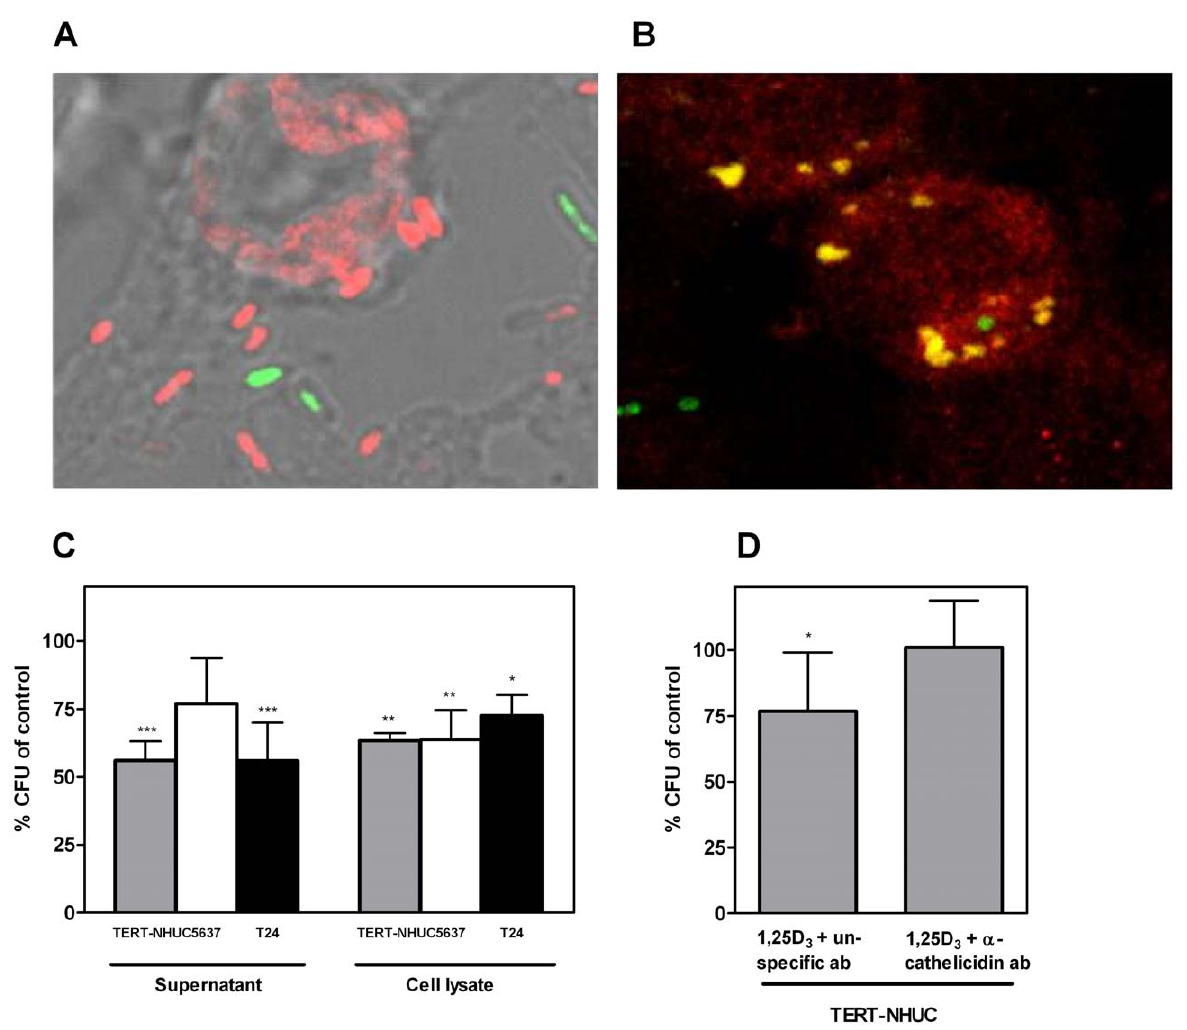
Figure 6. Vitamin D increases the cathelicidin-mediated antibacterial effect of bladder epithelial cells. Cell-associated UPEC are killed as determined with Live/Dead staining where live bacteria are stained green and dead bacteria are stained red ( A ). UPEC attach and invade bladder cells and are colocalized with cathelicidin. GFP-labelled E. coli CFT073 is green and cathelicidin is stained with AlexaFluor 594 (red); regions of colocalization are yellow ( B ). The antibacterial effect induced by 1,25D 3 was measured in medium from TERT-NHUC, 5637 and T24 bladder cells after stimulation for 48 hours. E. coli CFT073 was incubated in conditioned medium from treated cells for 90 minutes (Supernatant). Cells from the same experiment were harvested and lysed (Cell lysate). The resulting bacterial count is shown as percentage of vector treated control cells. Mean values with standard deviation are shown from three independent experiments; *** P , 0.001, ** P , 0.01 and * P , 0.05 (ANOVA with Dunnett’s post-test) ( C ). Adding a neutralizing anti-cathelicidin antibody ( a -cathelicidin ab) to the conditioned medium from TERT-NHUC bladder cells blocked the antibacterial effect, whereas conditioned medium in the presence of an irrelevant antibody maintained its antibacterial activity. Mean values with standard deviation are shown from four independent experiments; * P , 0.05 (ANOVA with Dunnett’s post-test) ( D